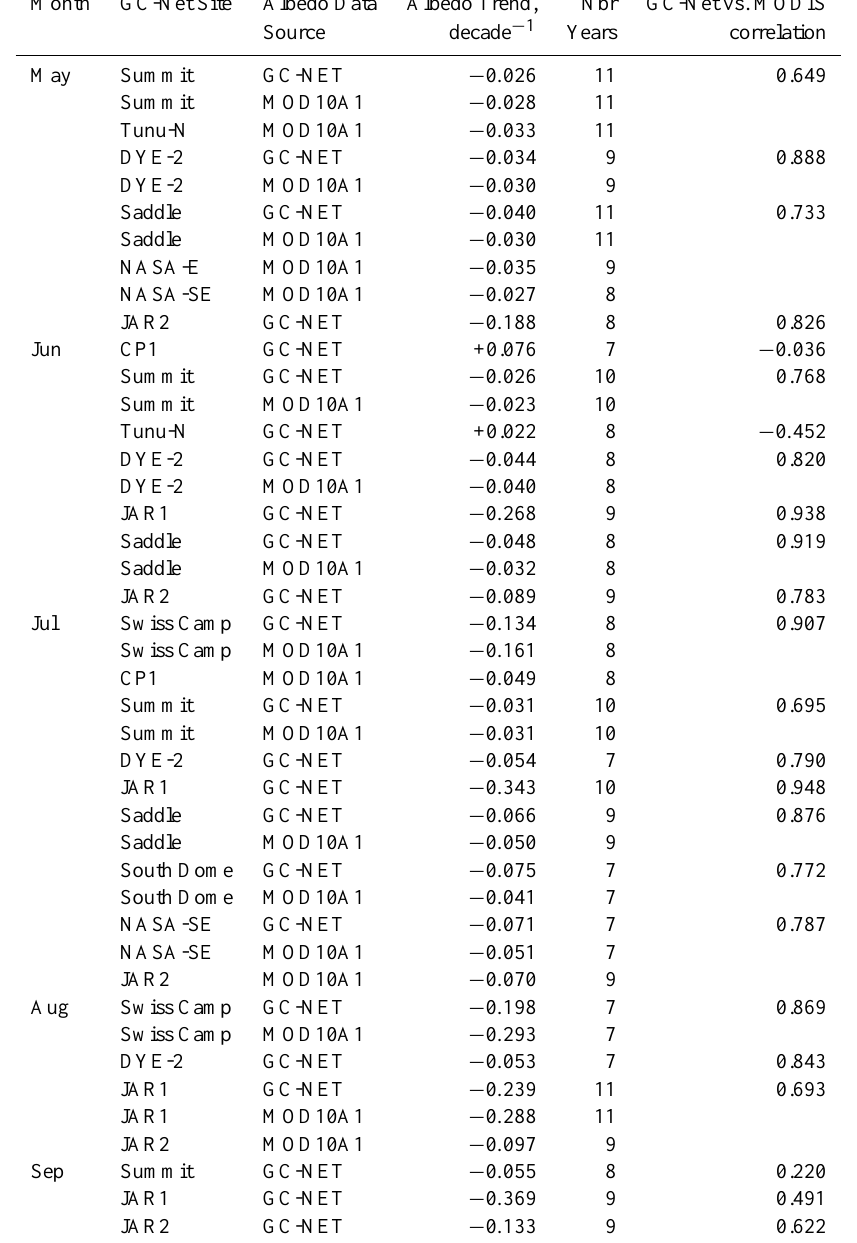
Table 1. Comparison of albedo trends in MODIS MOD10A1 and GC-Net observations for statistically significant cases.